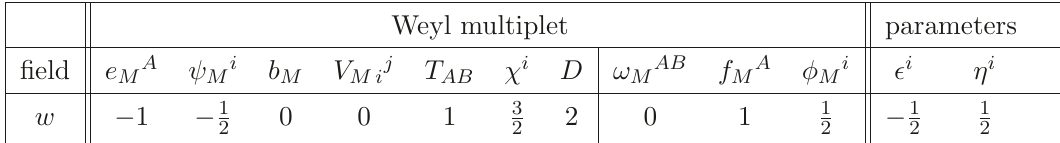
Table 1 . Weyl weights w of the 5 D Weyl multiplet component fields and the supersymmetry transformation